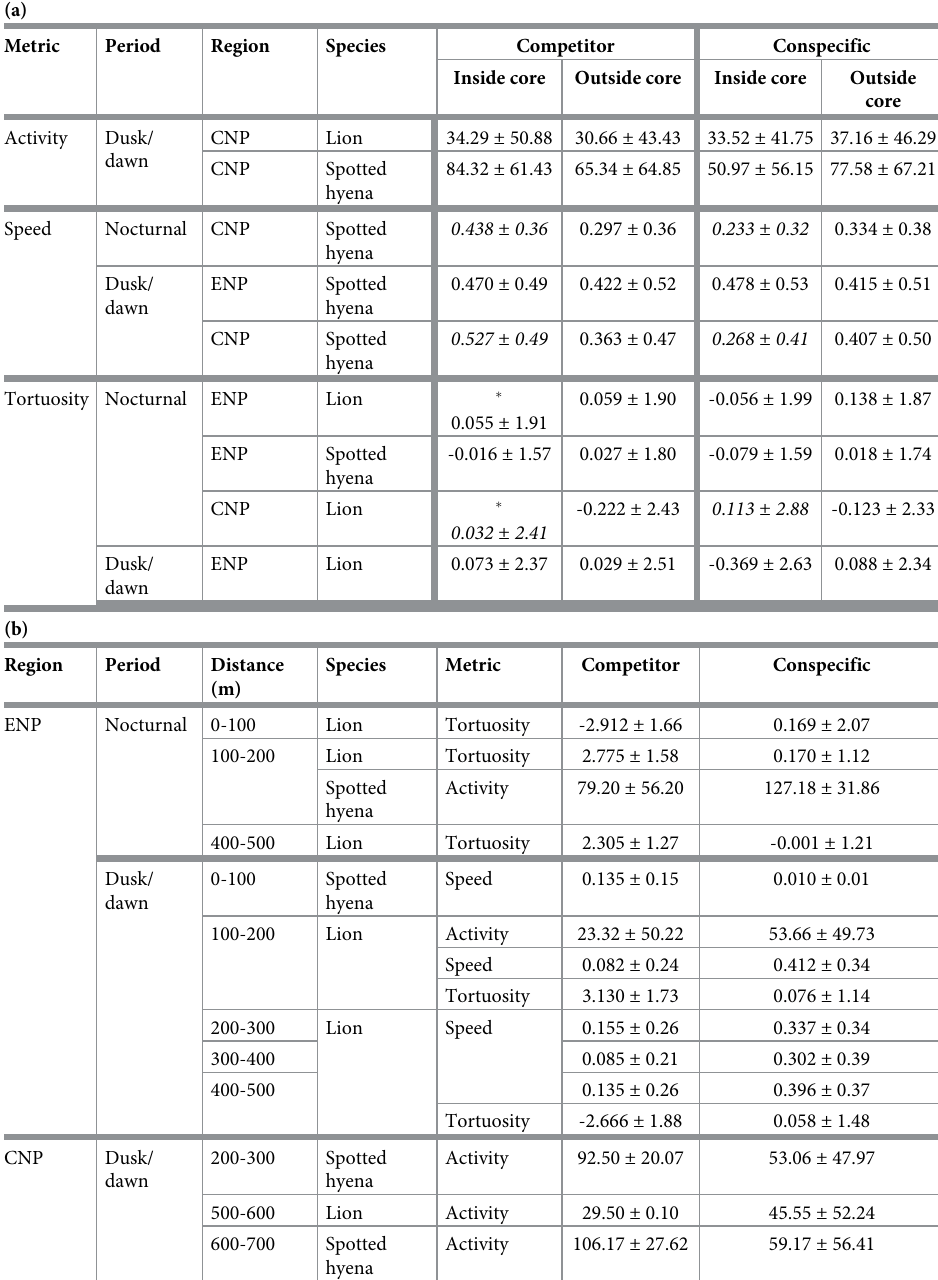
Table 8. Movement and activity metrics within competitor and conspecific core use